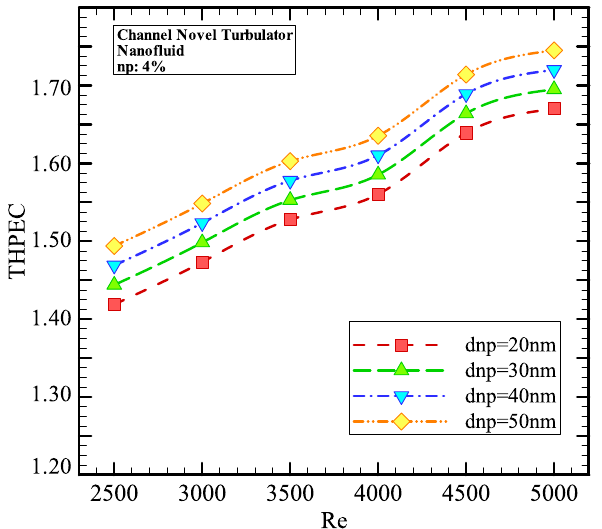
Figure 16. The THPEC variation versus Re in helical heat exchanger with novel turbulators saturated with nanofluid ( φ = 4%) in different nanoparticles diameters.